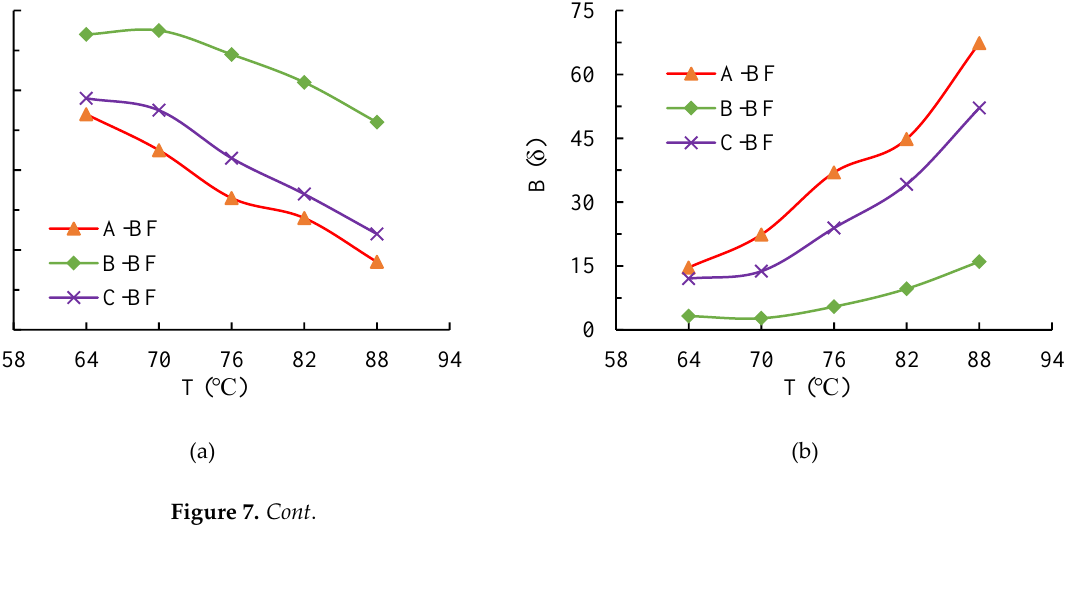
Figure 7. Indicators based on DSR: ( a ) A(δ), ( b ) B(δ), ( c ) A(G*) and ( d ) A(G’’) . Smaller A(δ) and larger B(δ), A(G*), and A(G’’) indicate stronger interfacial bonding between the asphalt mastic and BF. The following points can be seen in Figure 7.